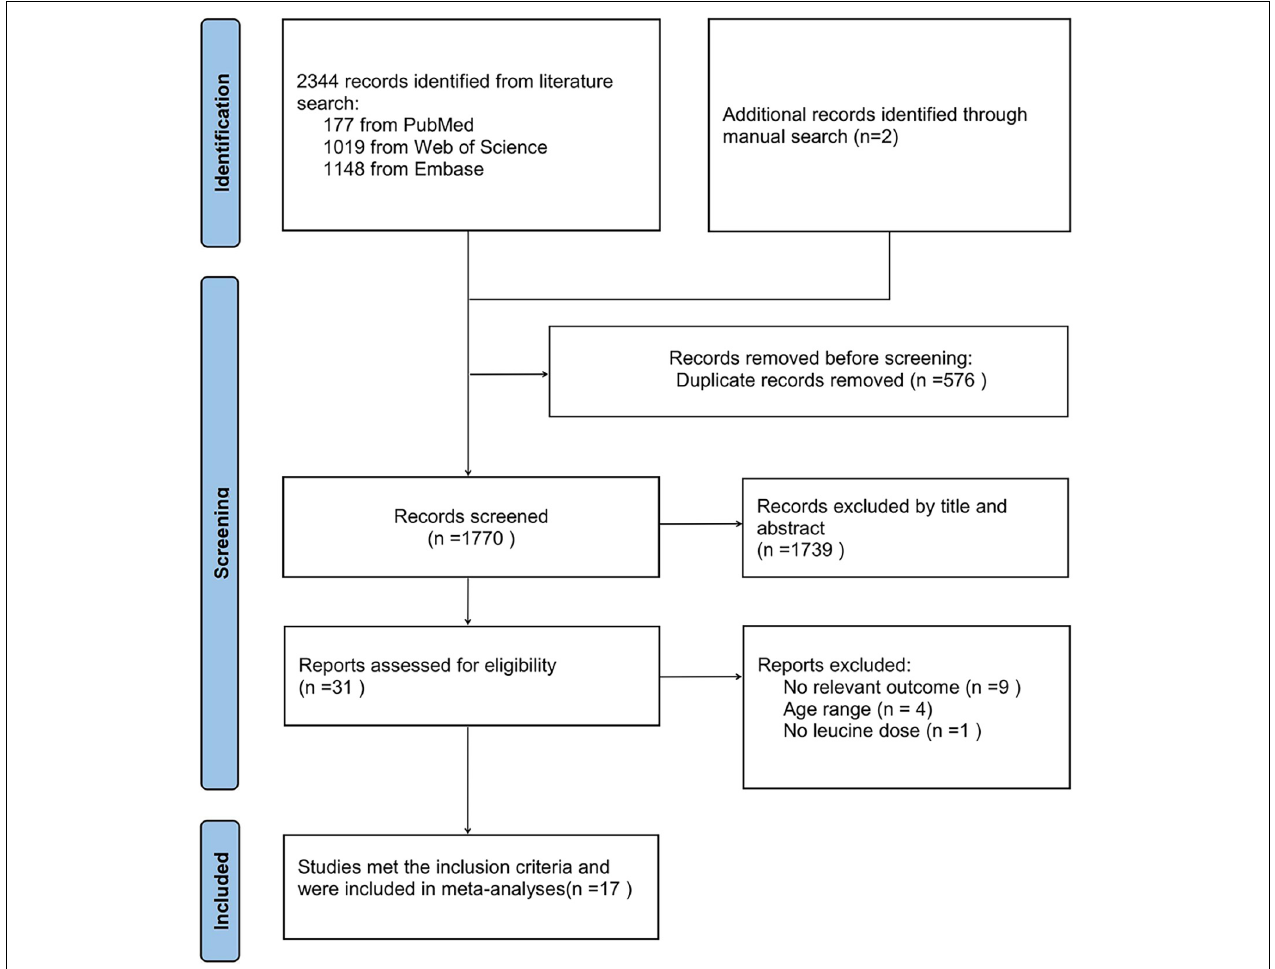
FIGURE 1 | Flow chart of the study screening and selection